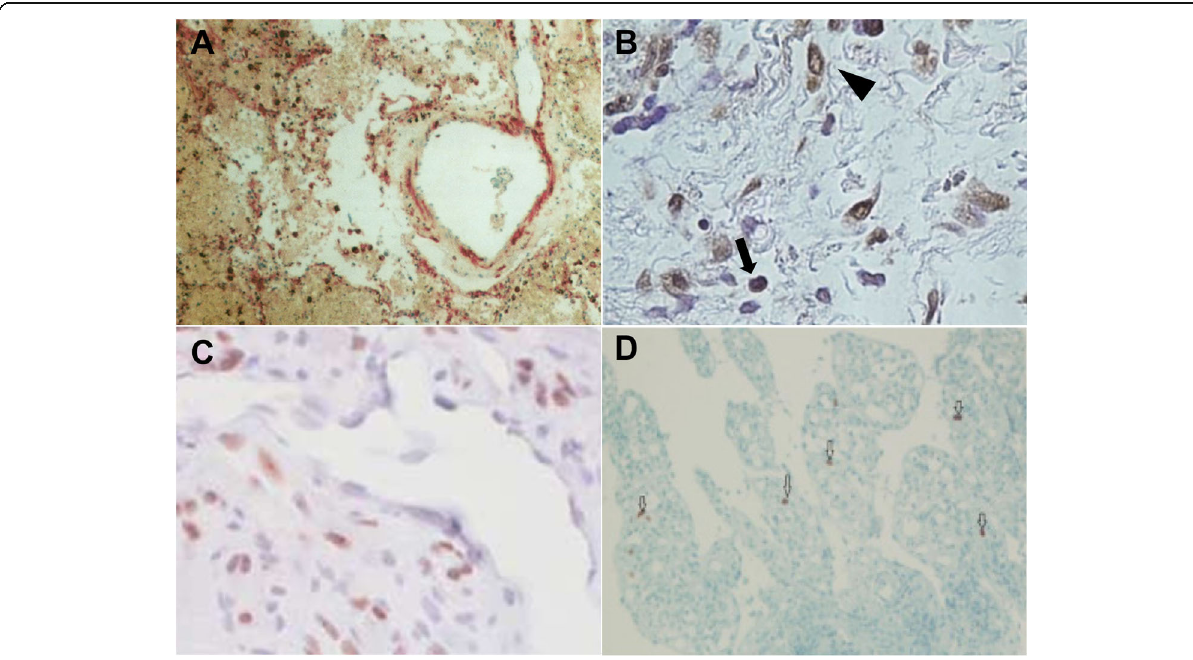
Fig. 5 A HSVI immunoreactivity in the lung (IBD4 monoclonal antibody). B . LMP-1 immunohistochemistry showing positive staining in B cells (arrows) and plasma cells (arrow heads). Scale bar = 50 μ m. C . Immunohistochemical staining for HHV-8 LNA-1 in cutaneous patch/plaque Kaposi sarcoma. D . Immunohistochemistry of CMV showing nuclear positive cells in ileal tissue.